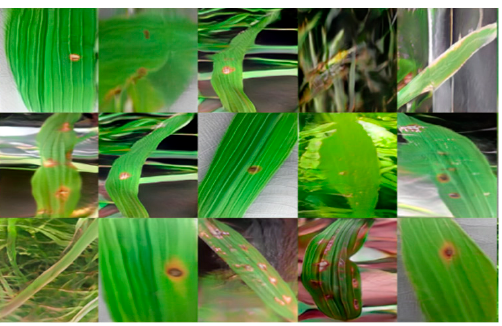
Figure 12. Synthetic images.